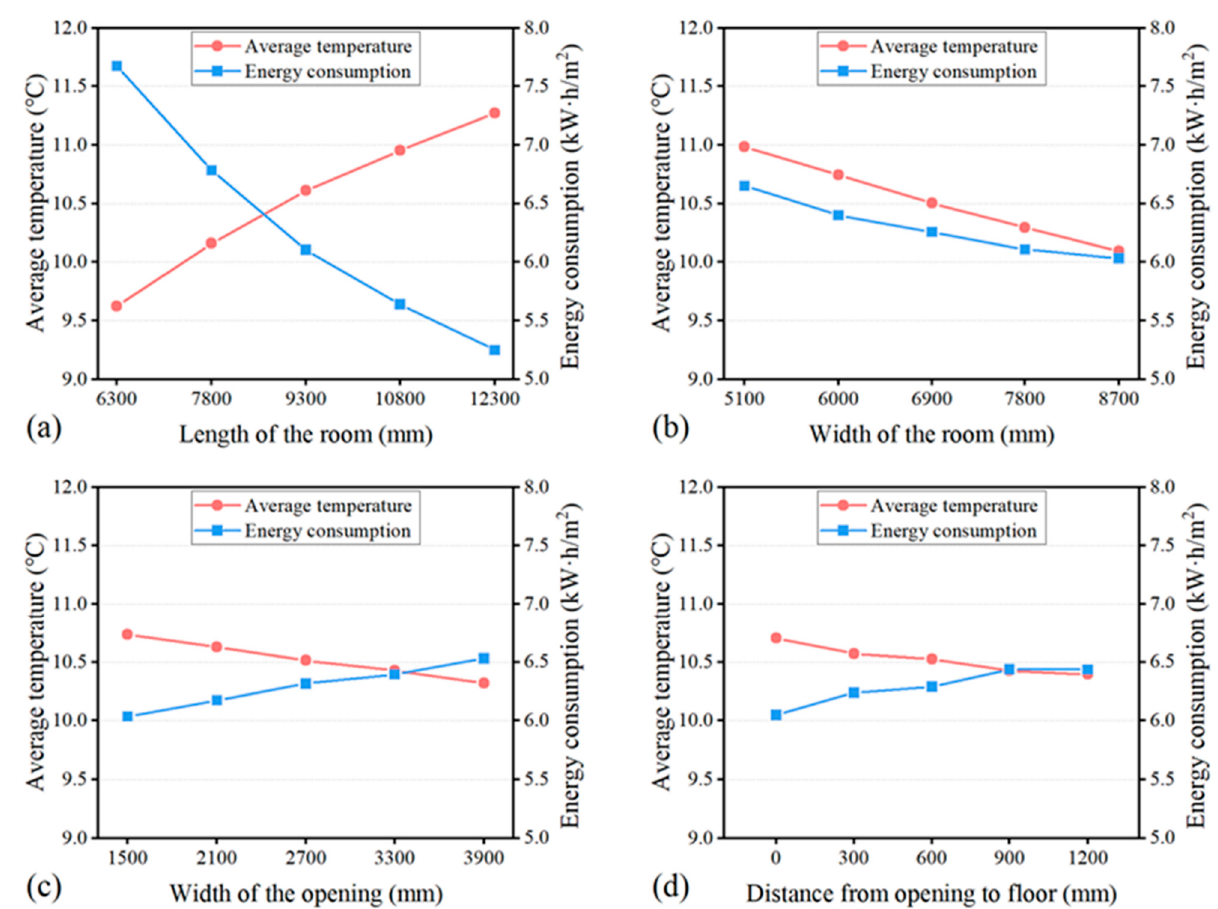
Figure 7. The effect curve of each test factor and the average indoor air temperature/room energy consumption per square meter. ( a ) The length of the room; ( b ) The width of the room; ( c ) The width of the opening on the north wall of the room; ( d ) The distance from the lower edge of the opening to the floor.